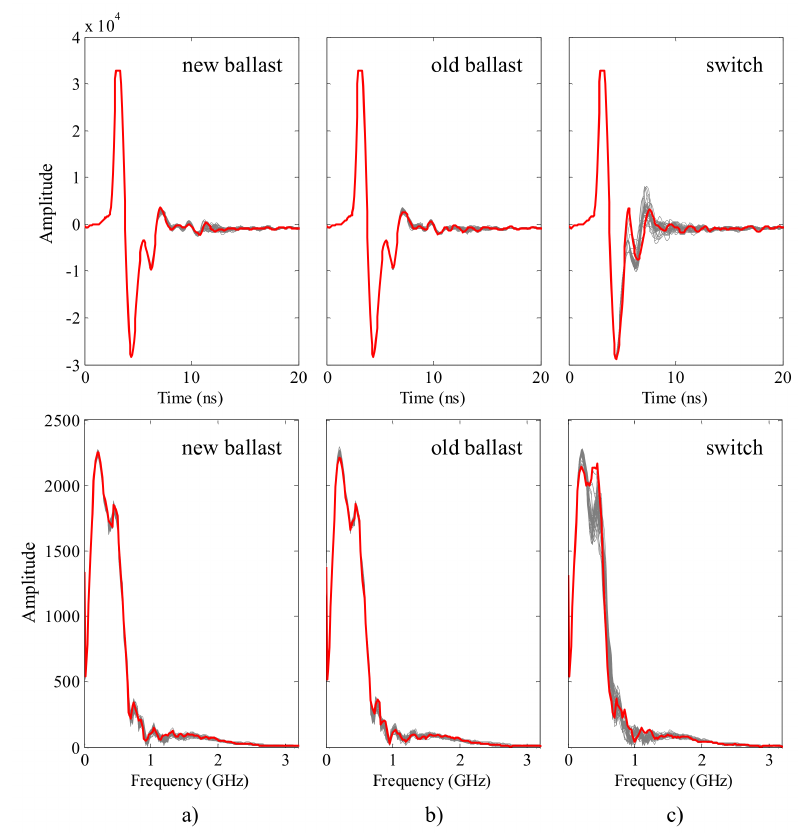
Figure 1. Example of Ground Penetrating Radar (GPR) signal in time and frequency domain for (see Figure 2): ( a ) new ballast, ( b ) old ballast and ( c ) over a